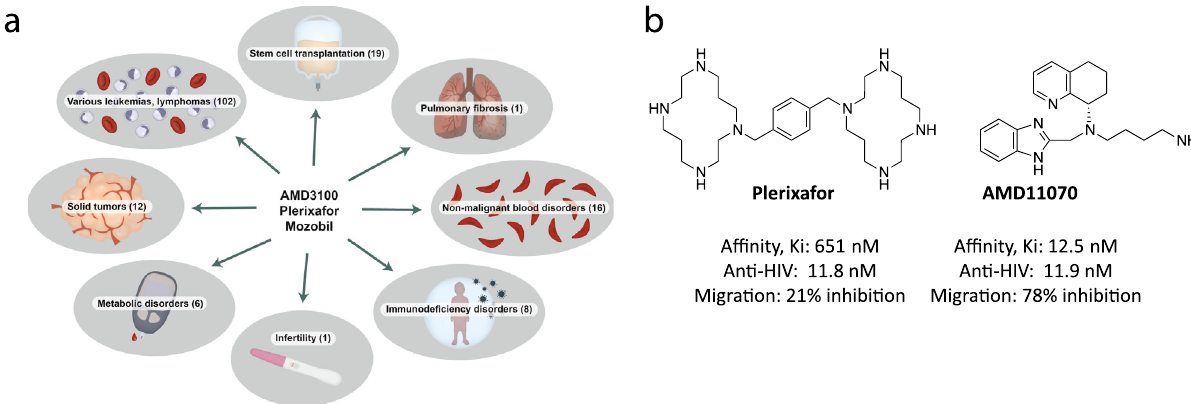
Fig. 1 Clinical trials involving plerixafor, and comparison of plerixafor vs AMD11070. a Overview of the types of clinical trials where plerixafor have been tested. The numbers in brackets show the number of trials within the different therapeutic areas. In scienti fi c literature, plerixafor is also known as AMD3100. The drug is used under the trade name Mozobil. This image was created by Anna So fi e Husted using Adobe illustrator and photoshop under the licence of University of Copenhagen. b Chemical structures of plerixafor and AMD11070. The values below show their binding af fi nity for CXCR4 measured as their ability to inhibit CXCL12 binding in competitive binding 22 , their ability to inhibit viral replication in MT-4 cells infected with the HIV-1 strain 21 , and their ability to block migration of the A375 melanoma cell line towards CXCL12 (10 nM) 23